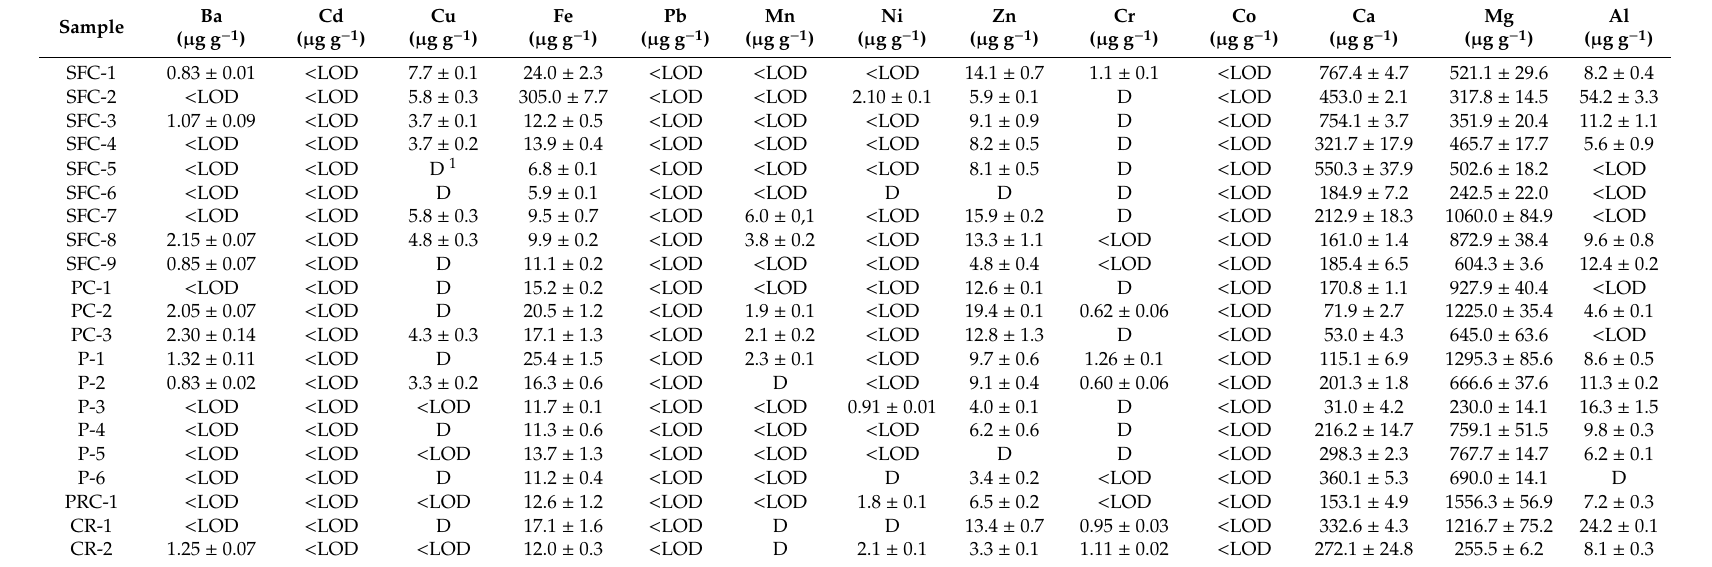
Table 6. Metal concentrations in commercial snack